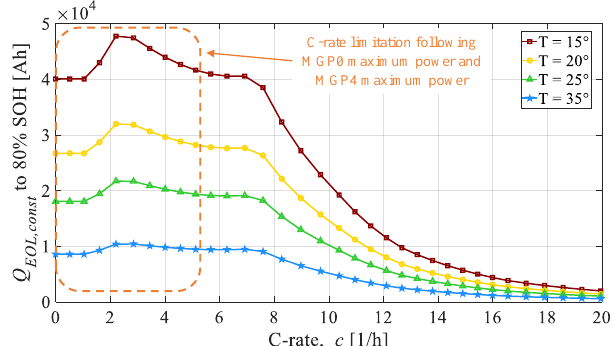
Figure 5. Allowed lifetime Ah-throughput predicted by the numerical ageing model as a function of the cell temperature and C-rate.